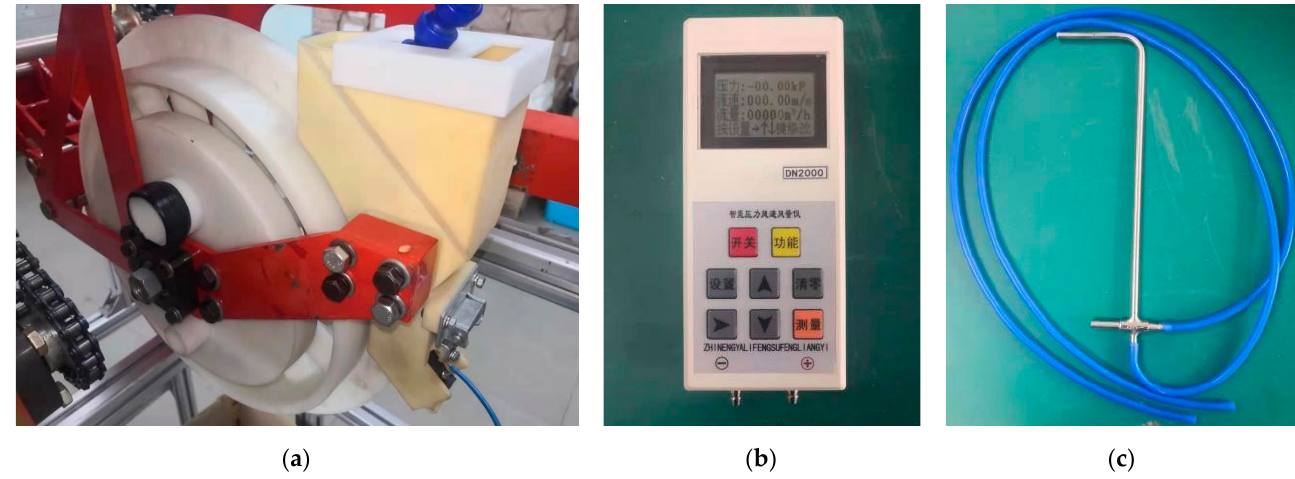
Figure 12. Test prototype and measuring equipment: ( a ) the prototype; ( b ) DN2000 intelligent anemometer; ( c ) the Pitot tube.